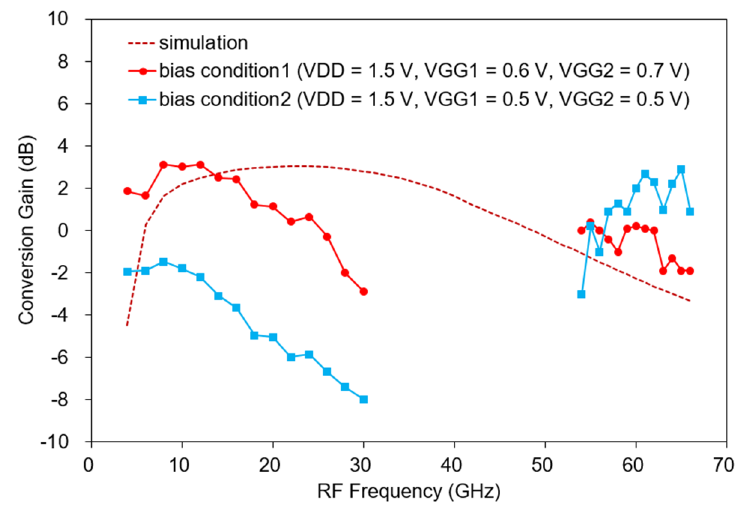
Figure 17. Measured CG versus RF (bias condition1: V DD = 1.5 V, V GG1 = 0.6 V, V GG2 = 0.7 V, bias condition2: V DD = 1.5 V, V GG1 = 0.5 V, V GG2 = 0.5 V, LO power = 8–10 dBm, RF power = − 30 dBm, IF = 650 MHz).